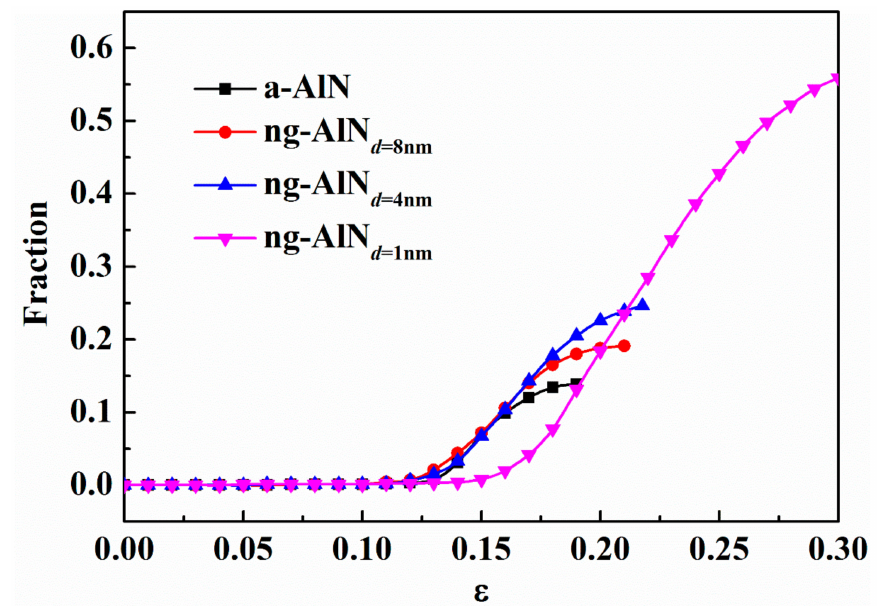
> 0.2 for a-AlN i